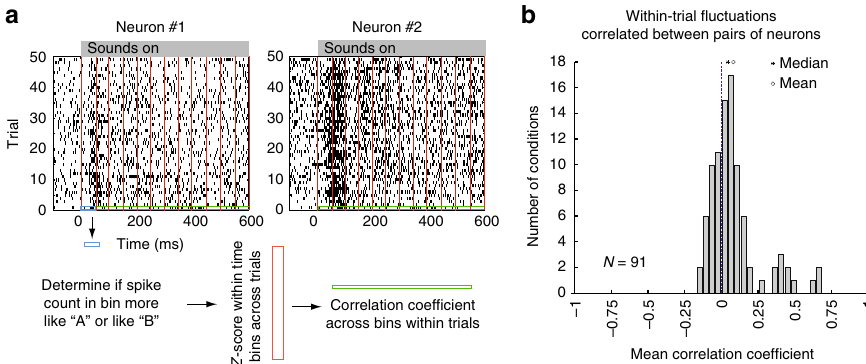
Fig. 4 Pairs of neurons tend to show positive within-trial correlations. a Schematics of the analysis. Raster plots of two neurons recorded simultaneously; trials shown are for a particular set of dual-sound conditions. We evaluated the spike count in a given 50 ms time bin, trial, and member of the neuron pair for a given set of dual-sound conditions to determine if it was more similar to the spikes evoked during that bin on the corresponding sound A alone or B alone trials (blue box). We then converted these A vs. B assignment probabilities to a Z -score based on the mean and standard deviation of the assignment probabilities in that time bin on the other trials that involved the same stimulus conditions (red box). Finally, we computed the correlation coef fi cient between the set of Z score values for a given trial between the pair of simultaneously recorded neurons (green box). b Across the population of pairs of triplets recorded simultaneously, the distribution of mean correlation coef fi cients tended to be positive ( t -test comparing the mean correlation coef fi cients to zero; p = 6.8 × 10 -6 ). See Supplementary Figure 8 for the same analysis based on spike counts and broken down according to whether the neurons in the pair shared the same or had different preferences for sound A vs. sound